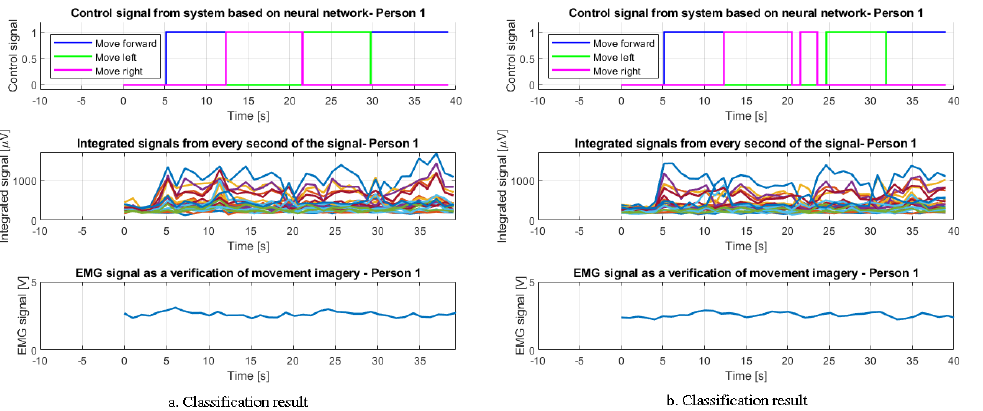
Figure 18. Observation of the signal classification and verification results—Person 1.